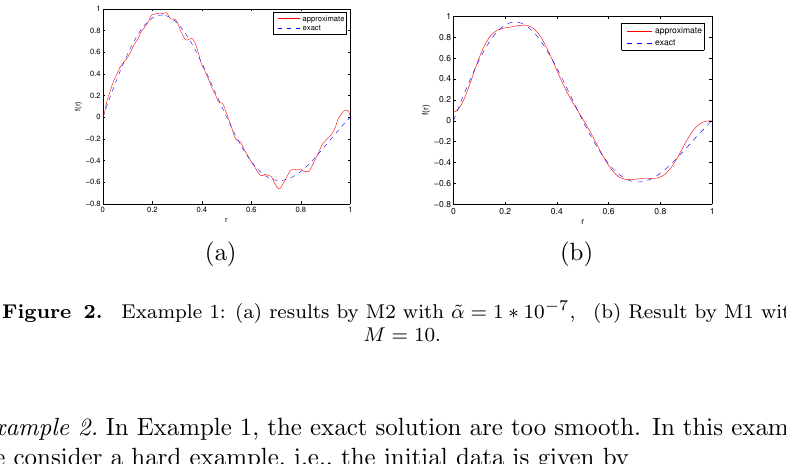
When α = 0 . 5 and δ = 1%, we use the regularization methods M1 and M2 to construct the approximation. The results are displayed in Figure 2 (a) and (b). From them it is easy to see that the presented methods are effective.